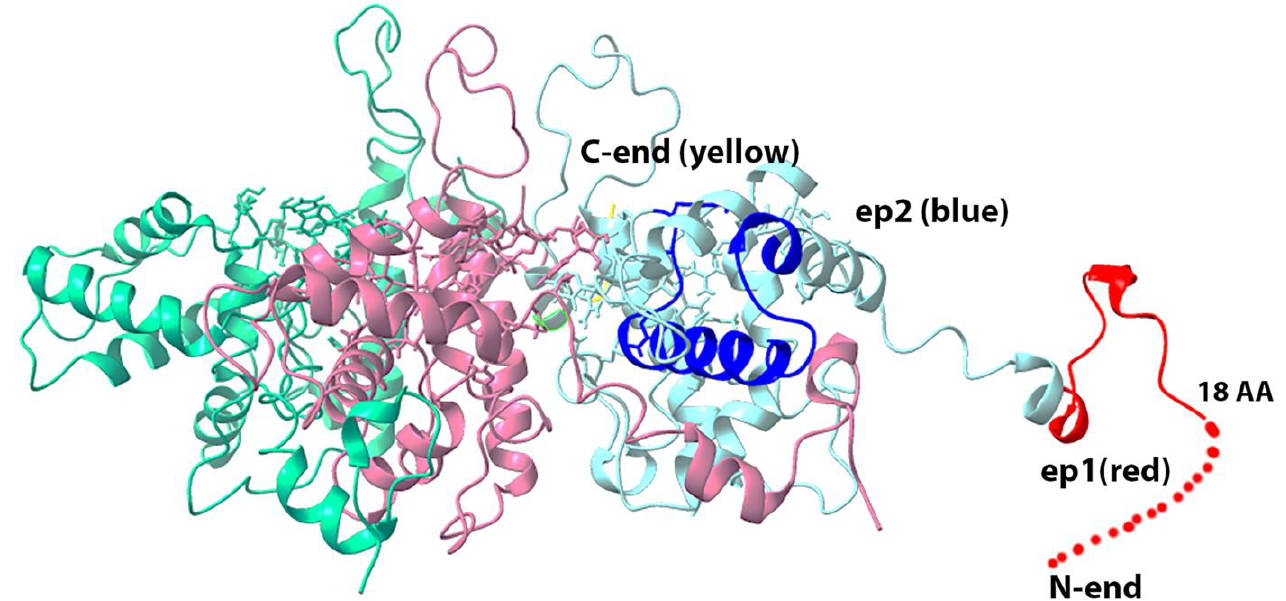
Figure 4. Three-dimensional model of the BYV virion fragment, based on the Pepino Mosaic Virus structure (5fn1.pdb rcsb.org). Red color designates ep1 , deep blue color designates ep2 , yellow color designates C-terminus of CP that is located inside the virion, while dashed line marks the disordered part of the epitope, whose structure could not be determined.